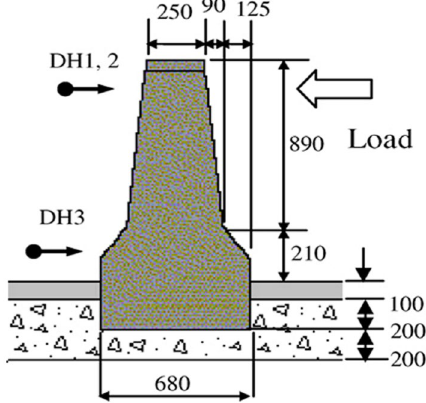
Fig. 24 The F shape concrete barrier